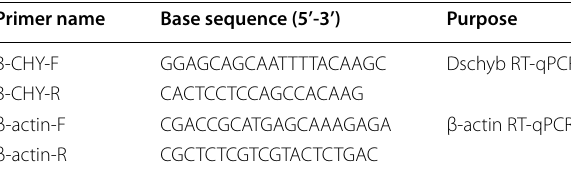
Table 3 The primers for RT-qPCR